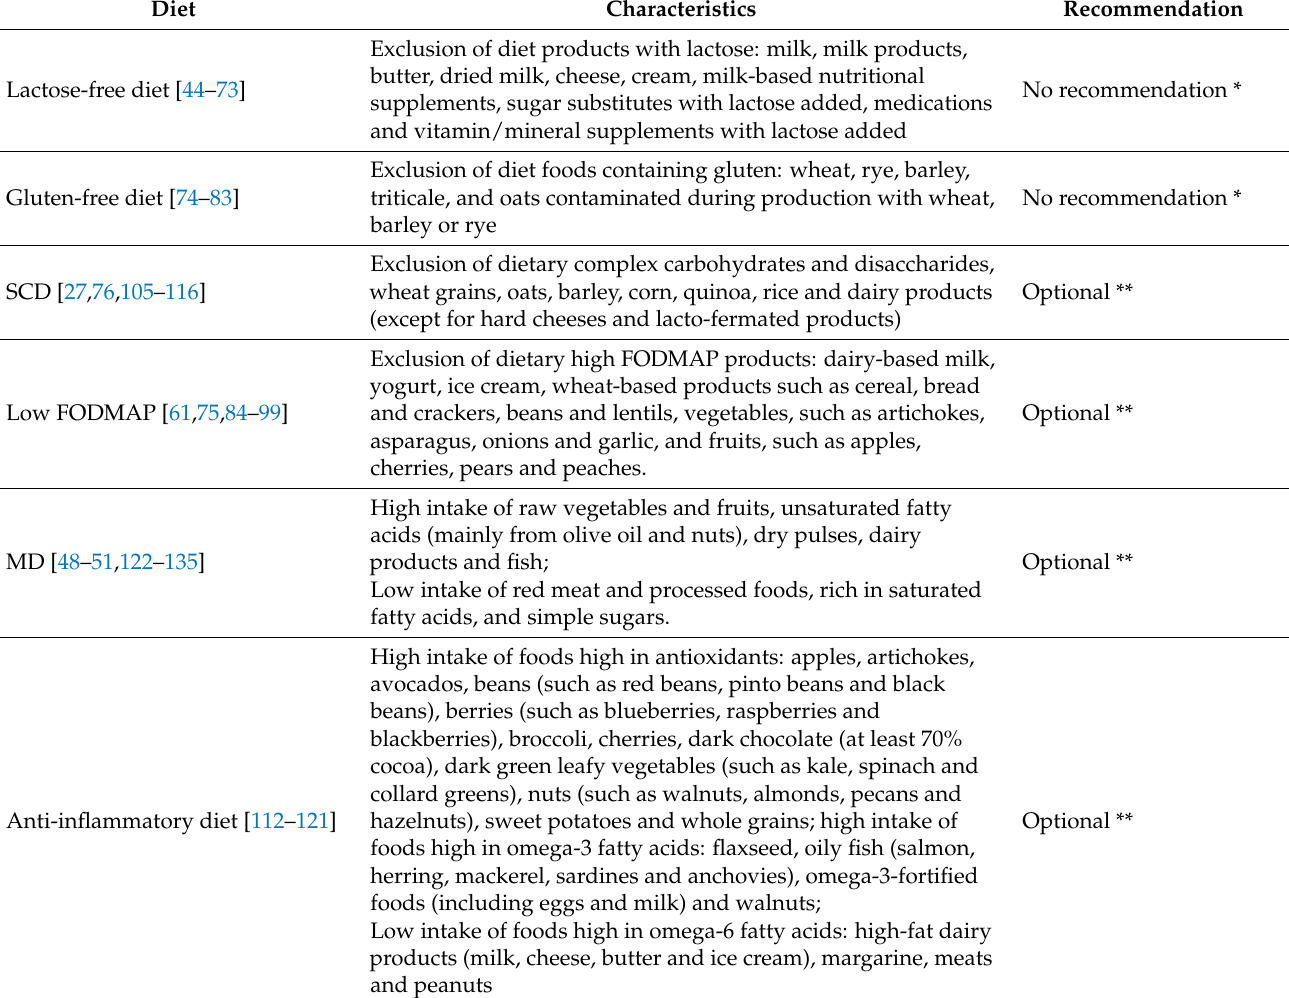
Table 2. Evidence-based diet recommendations for the maintenance of remission in IBD. Characteristics